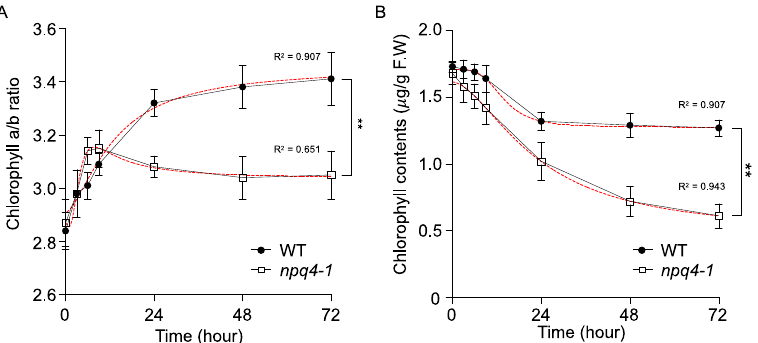
Figure 7. Change in chlorophyll a/b ratio and chlorophyll contents in wild-type and npq4-1 mutants during high light illumination. ( A ) Chlorophyll a/b ratio reflects LHCII proportion of photosystem during the HL treatment; ( B ) Chlorophyll contents during HL treatment were expressed as μ g (g FW) − 1 . Fresh weight was determined after HL treatment. Regression line plotted as red dashed line estimated via nonlinear least square regression. R 2 denotes the regression coefficient. Significance differences of fitted curves are indicated by asterisks (** p < 0.01) compared to the WT as determined by unpaired Student’s t test.